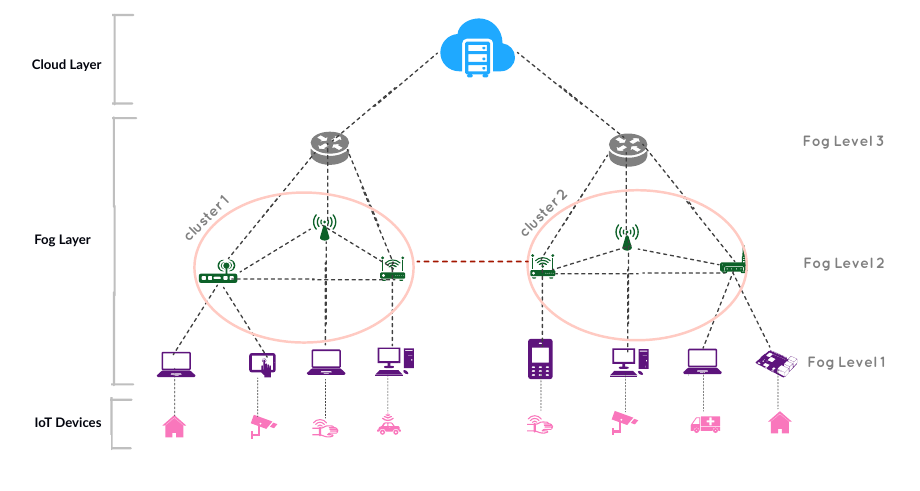
Figure 1. Proposed system architecture including 3 layers of Internet of Things (IoT), fog, and the cloud, while encompassing 3 fog